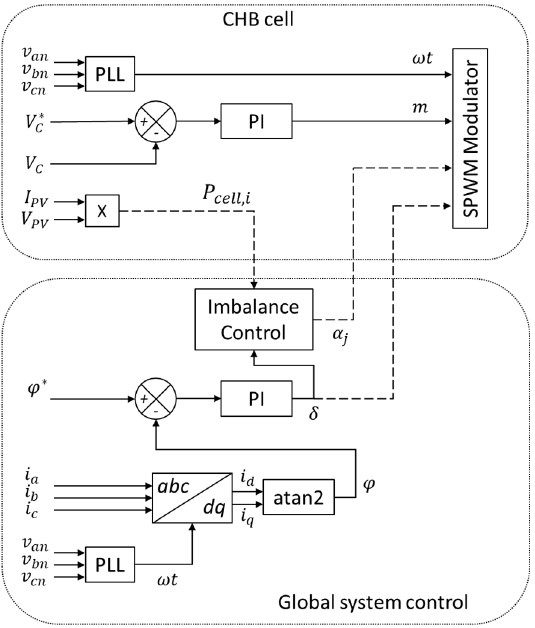
Figure 3. Control scheme